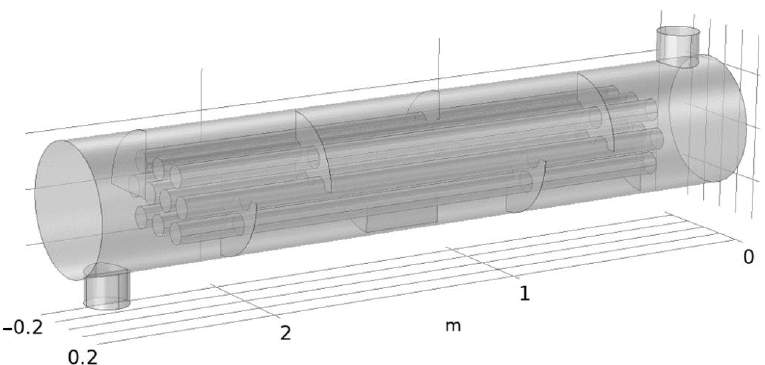
Figure 5. Model 3. Figure 5. Model 3.